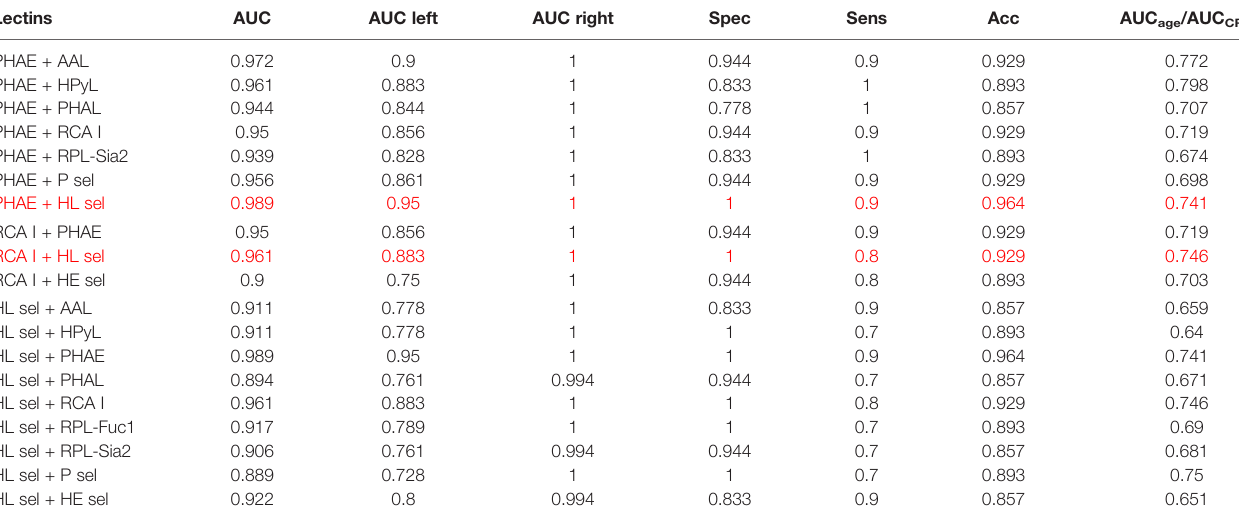
TABLE 3 | Clinical performance characteristics of double lectins for the CRC matrix with the best combinations showed in red. Lectins AUC AUC left AUC right Spec PHAE +